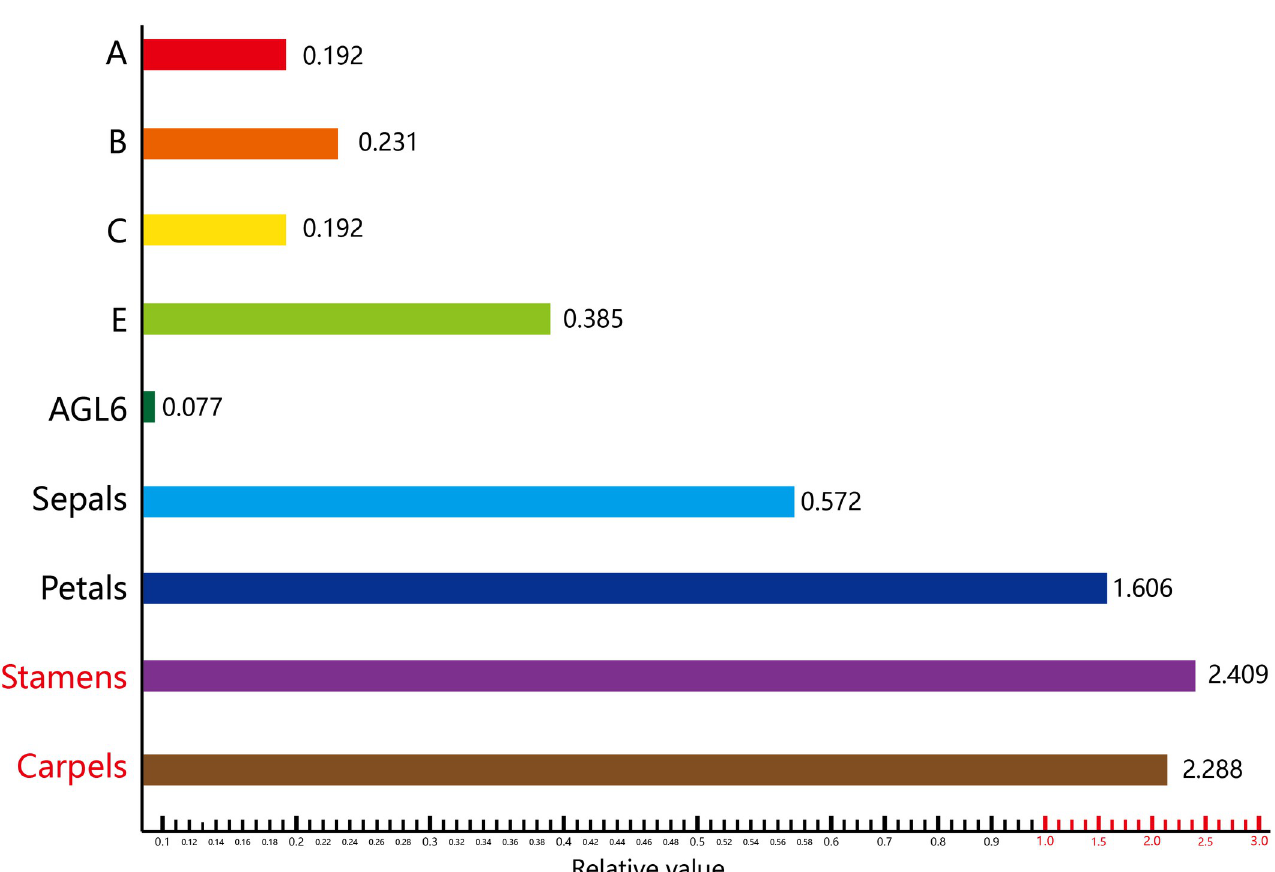
Fig 4. The contribution values of the ABCDE and AGL6 genes and the gradient values of the floral organs. The flower formation contribution values of the ABCDE genes are as follows: A gene, 0.192; B gene, 0.231; CD gene, 0.192; and E gene, 0.385. The gradient value of the floral organs refers to the product of the importance values of floral organs and the ABCDE flower formation contribution value. The gradient values of the floral organs: 0.572; petals, 1.606; stamens, 2.409; and carpels, 2.288.